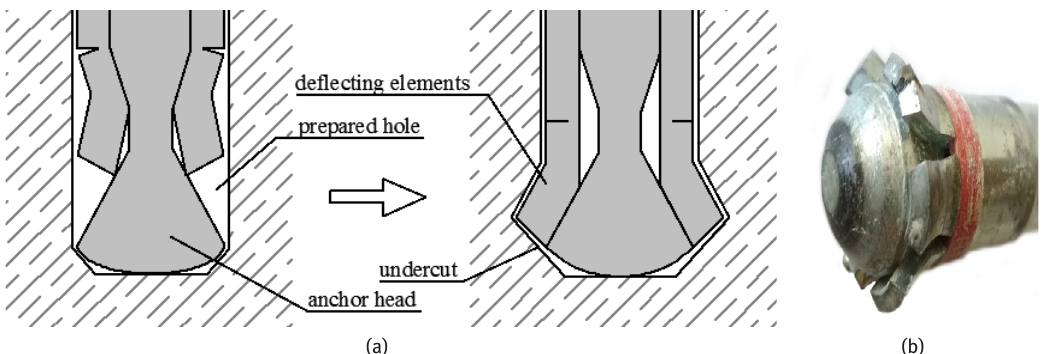
Figure 2: a) scheme of mounting the anchor, b) used anchor.